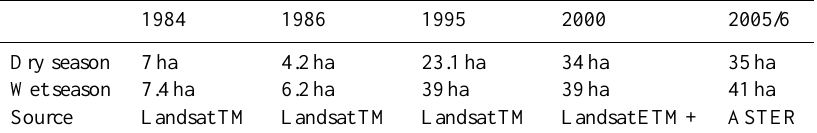
Table 6. Time-series of pond size.